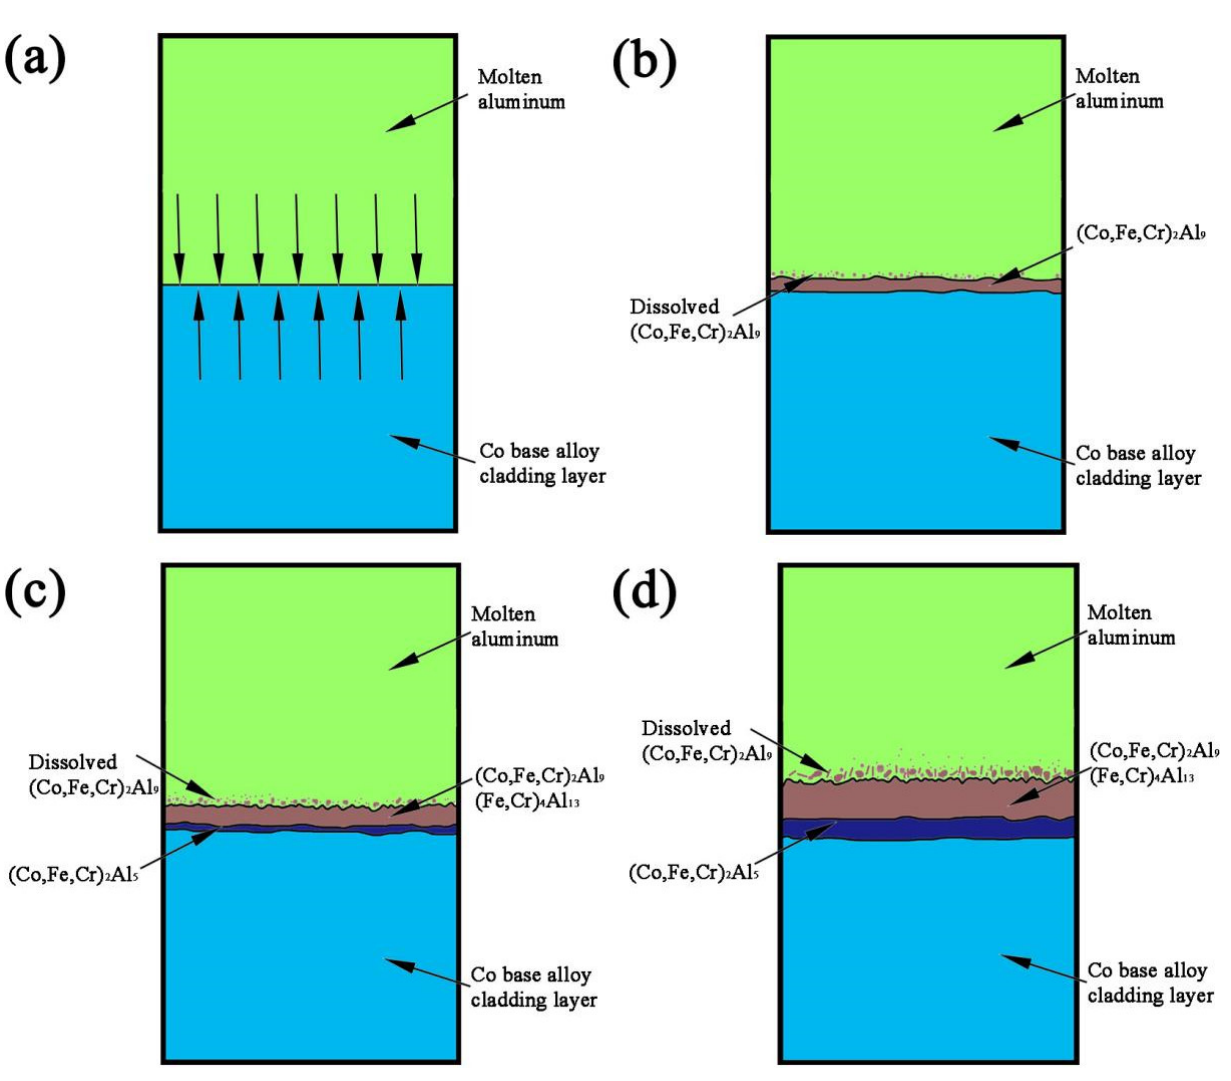
Figure 10. Schematic illustration of resistance to molten aluminum corrosion as enhanced by laser cladding Co-based alloy coating on H13 steel surface: ( a ) the initial stage of the aluminum erosion; ( b ) the formation of the IMSs in Layer A; ( c ) the formation of the IMSs in Layer B and ( d ) the stable stage of the aluminum erosion.